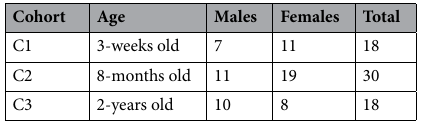
Table 1. Oryctolagus cuniculus sample demographics.